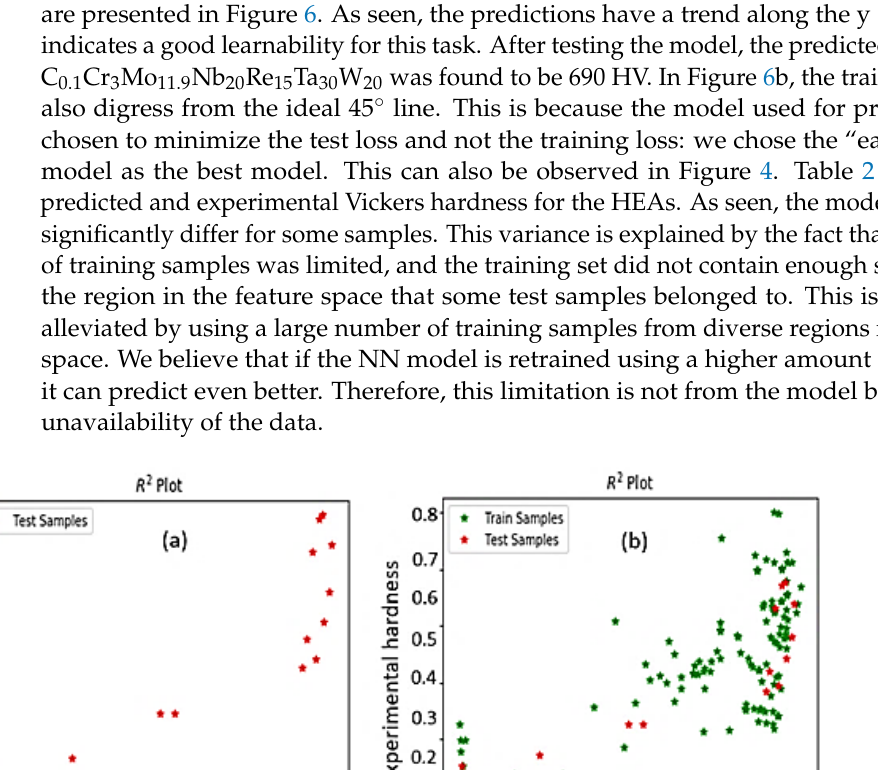
Figure 5. Error bars for the uncertainty among the trained models on test samples.